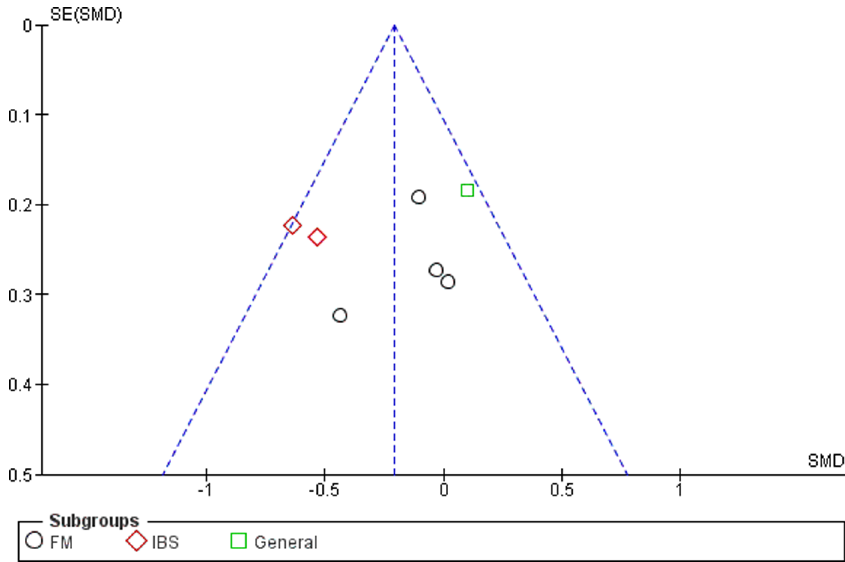
Figure 3. Funnel plot for symptom severity.